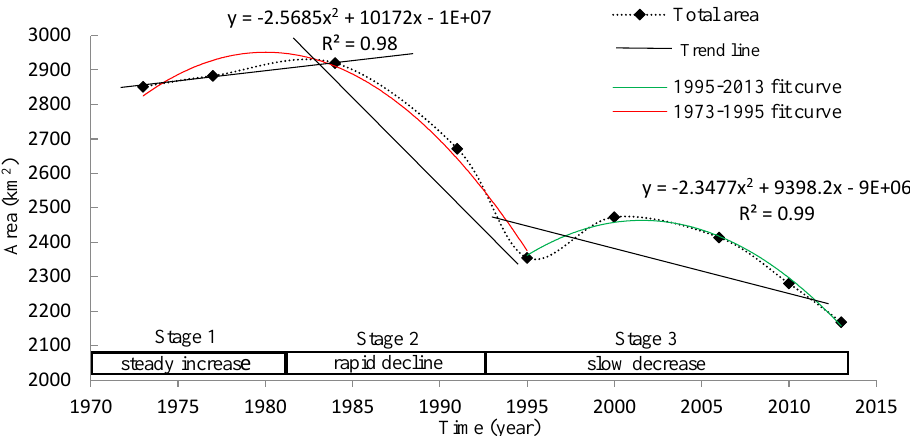
Figure 10. Change trends and mode of total wetlands area in the Yellow River Delta from 1973 – 2013.